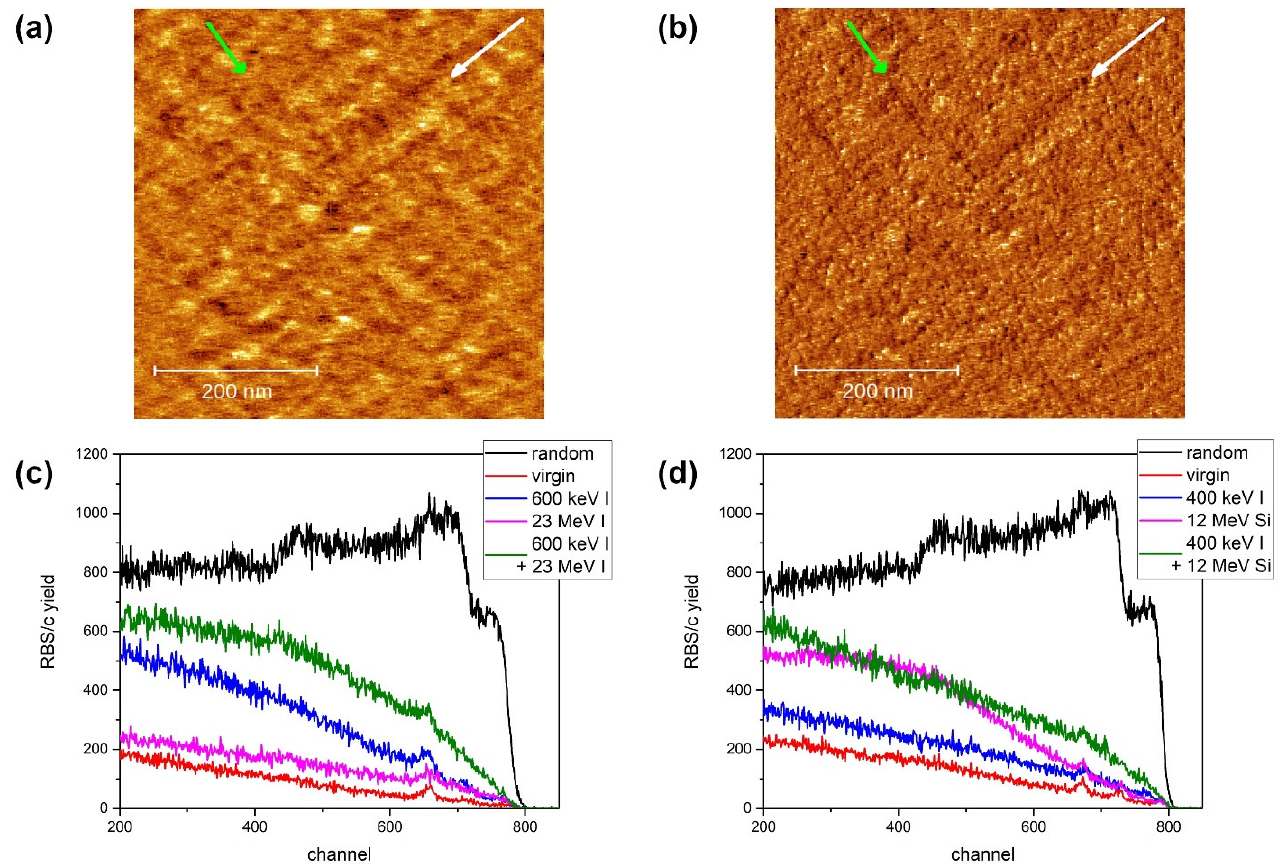
Figure 2. AFM image (500 nm × 500 nm, 1 nm false colour height scale) of MgO surface irradiated with 5 MeV Si (direction indicated by green arrow) and 12 MeV Si (direction indicated by white arrow) ion beams at a grazing incidence angle of 1.5 ◦ ( a ) and the corresponding friction map ( b ). ( c ) RBS/c spectra of sequentially irradiated MgO with 600 keV I (10 14 ions/cm 2 ) and 23 MeV I (10 14 ions/cm 2 ). ( d ) RBS/c spectra of sequentially irradiated MgO with 400 keV I (10 14 ions/cm 2 ) and 12 MeV Si (3 × 10 15 ions/cm 2 ).